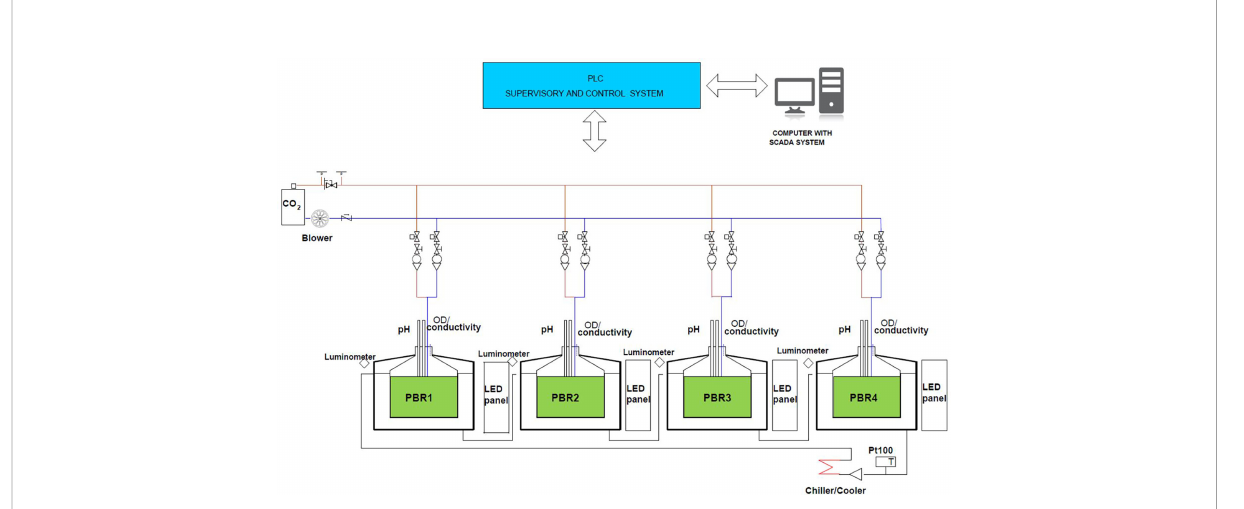
FIGURE 1 A scheme of 4 photobioreactors (PBR). Temperature, air/CO 2 bubbling, pH, light intensity and diurnal cycle are controlled by SCADA system (Blaz ̌ ina et al.,